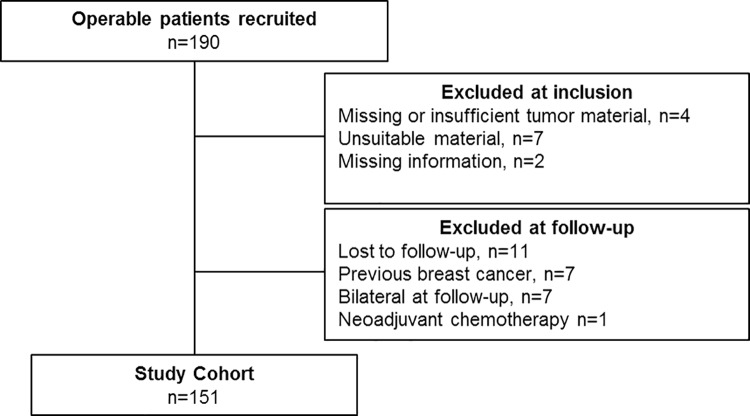
REMARK diagram illustrating patient flow in the study.